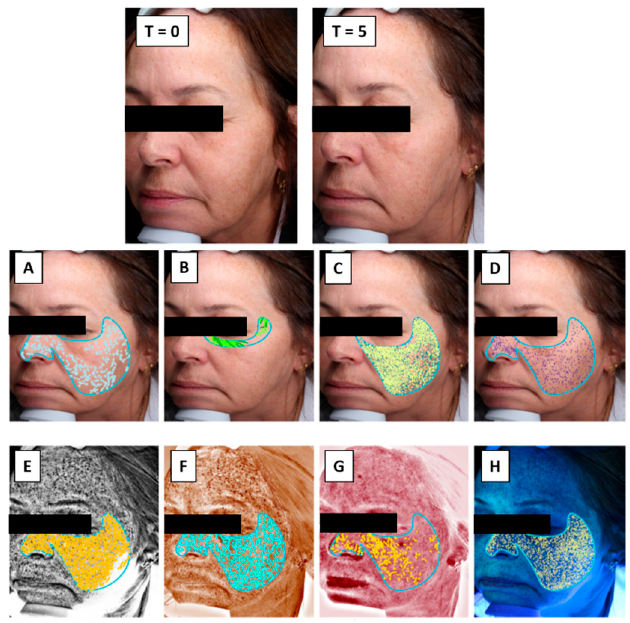
Figure 2. Typical photograph from skin multispectral imaging evaluation. A = Spots; B = Wrinkles; C = Texture; D = Pores; E = UV spots; F = Brown spots; G = Red spots; H = Porfirines.